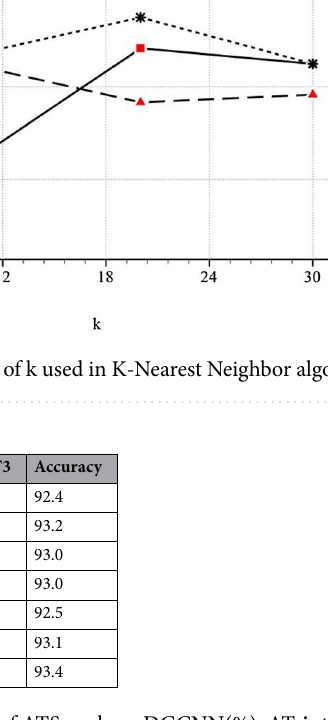
Table 3. Ablation study of ATSearch on DGCNN(%), AT i stands for using ATsearch at layer i .